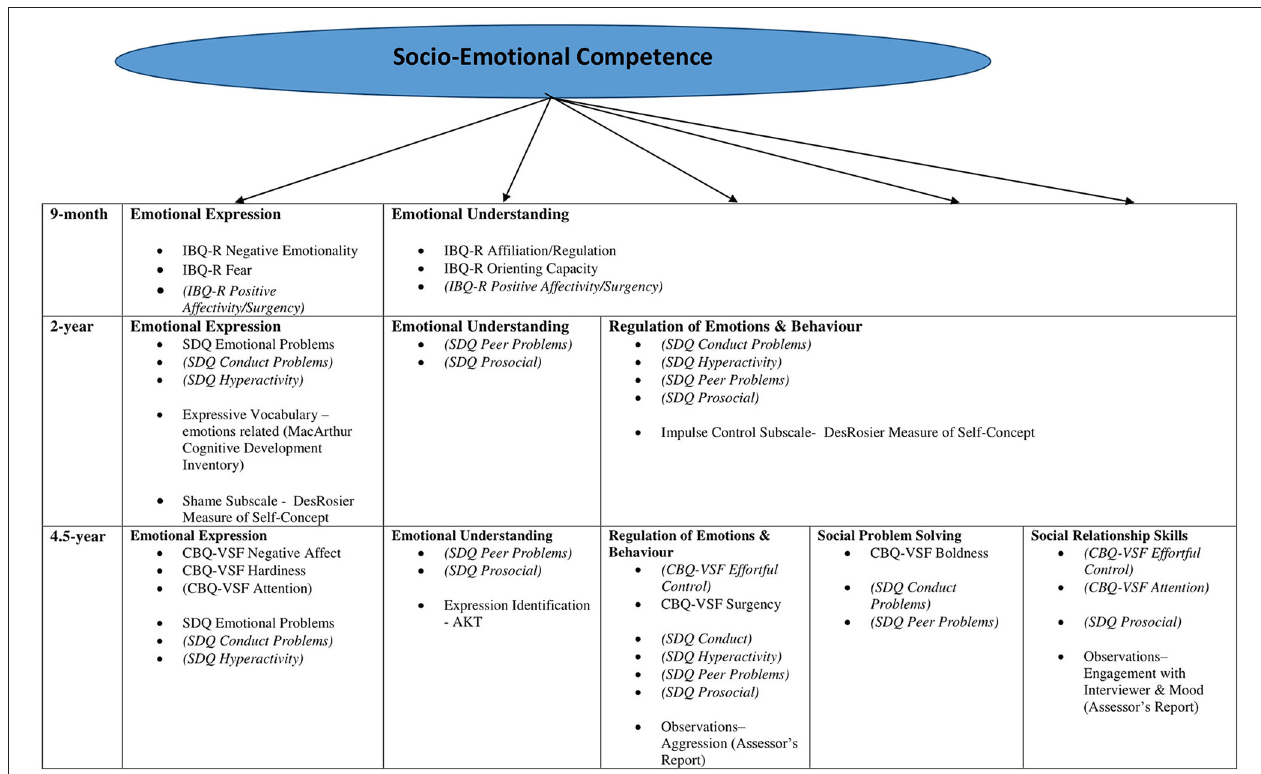
FIGURE 1 | Variable selected for the index of socio-emotional competence and their expected categorization. Variable that could be argued to fall under more than one component of socio-emotional competence are italicized and in